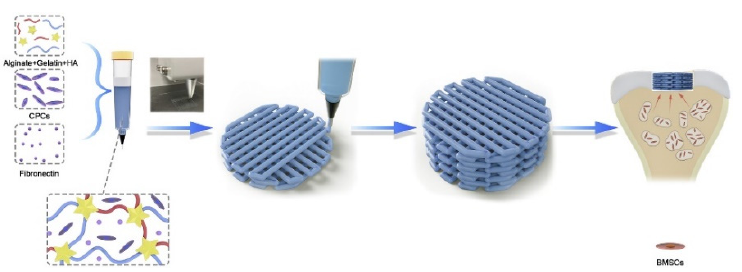
Figure 6. 3D printing schematic diagram of chondrogenic progenitor cells (CPC) and fibronectin (FN) encapsulated in biofilm for repairing cartilage defects [117].